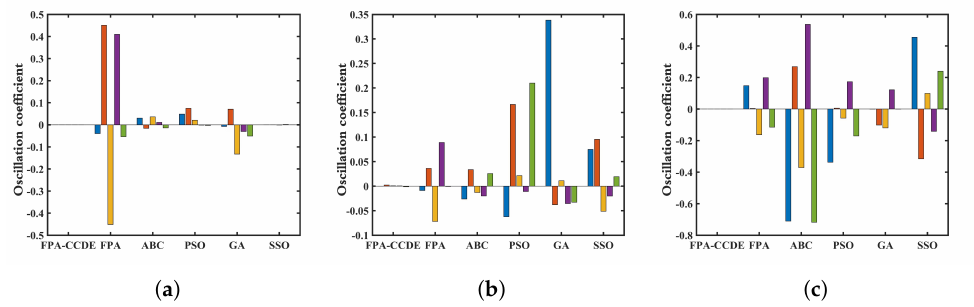
Figure 5. Stability of different algorithms: ( a ) stability on F36; ( b ) stability on F24; ( a ) stability on